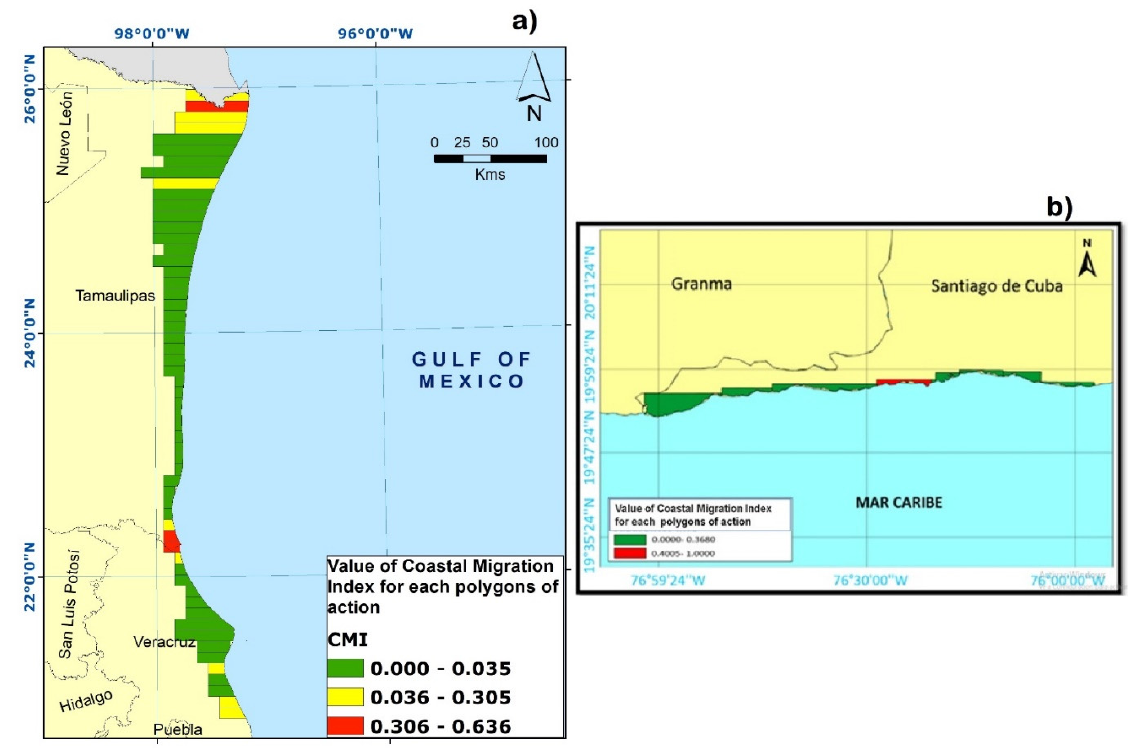
Figure 6. Graphical representation of the CMI value achieved by country. Caption: ( a ) representation of 57 polygons classified for Tamaulipas (Mexico) according to the ranges of interpretation in the stoplights presented in Appendix C. ( b ) 9 polygons showed in Appendix D for the study case of Guama (Cuba).